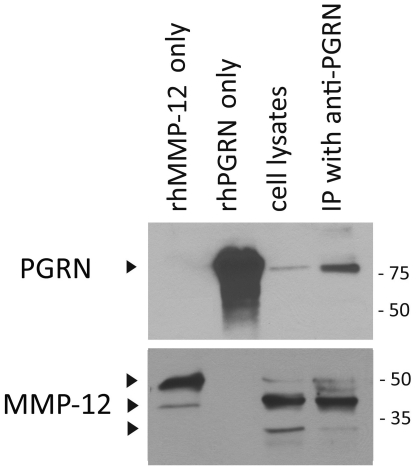
PGRN interacts with MMP-12 in microglia.Microglial cell lysates (untreated, control culture) were immunoprecipitated (IP) with anti-PGRN antibody and immunoblotted with anti-PGRN or anti-MMP-12 antibody. Recombinant MMP-12, PGRN, and non-IP microglial cell lysates were also analyzed in parallel. Microglial cell lysates show ∼90 kDa PGRN and ∼54, 45 and 22 kDa MMP-12 bands (arrowheads). Following IP with anti-PGRN, the ∼45 kDa MMP-12 band is prominent, indicating that PGRN and active MMP-12 interact with each other in microglia.